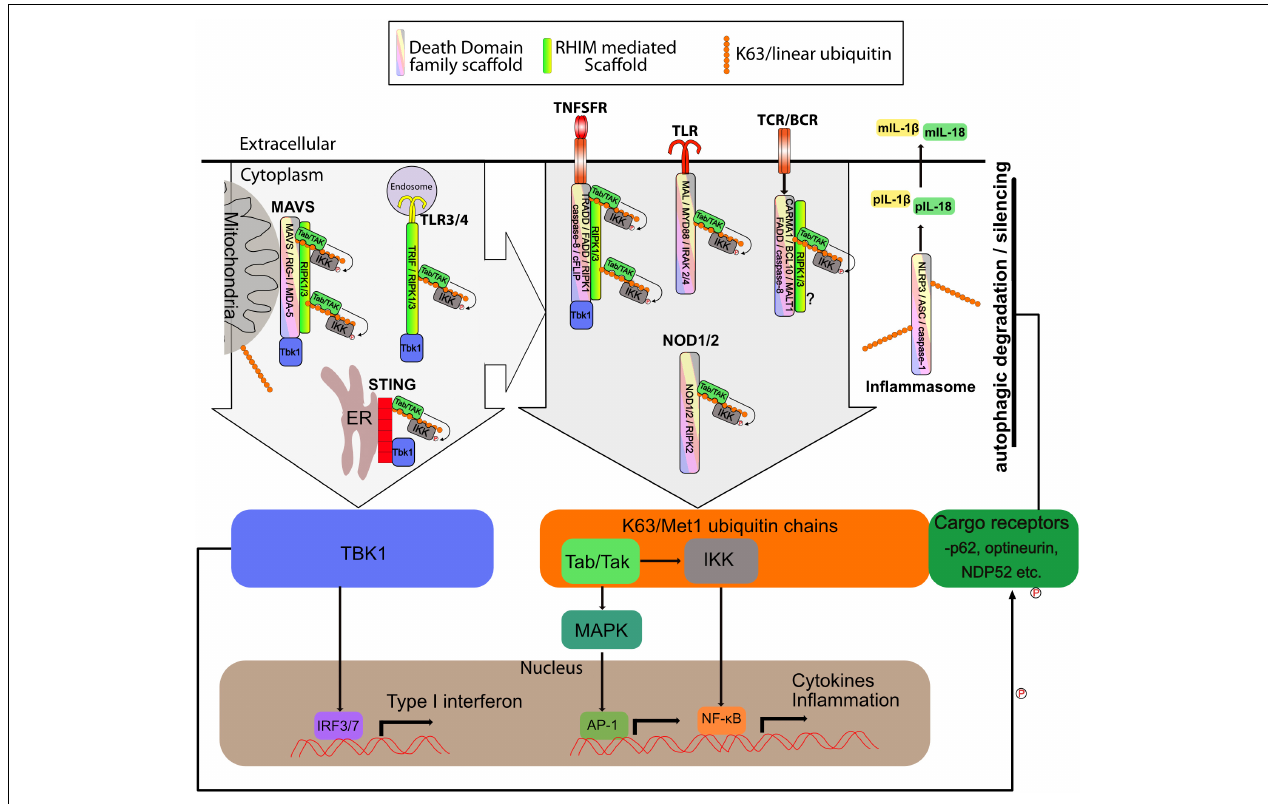
FIGURE 3 | Supramolecular signaling complexes in inflammation share common scaffolds and signaling pathways. The supramolecular signaling complexes formed by TLR, TNFSR, NOD1/2, STING, MAVS, Carma, BCL-10, MALT1 (CBM) and inflammasome complexes are indicated. Shown are the core scaffolds formed through death domain family interactions as well as RHIM interactions. STING contains no death domain family member or RHIM. Specific proteins known to interact through death domain interactions and RHIM interaction are indicated within each complex. Recruitment of TBK1 and/or K63/linear ubiquitin is indicated. TBK1 recruitment activates IRF3 to induce interferon responses. K63/linear ubiquitin recruits the TAB/TAK and IKK complexes which result in activation of NF-kB and Map kinase transcriptional responses. Also shown is linear/K63 ubiquitination of ASC of inflammasomes which can promote their assembly and activation or degradation. Complexes and organelles such as mitochondria that are k63 ubiquitylated recruit autophagy cargo receptors such as p62. This leads ultimately to degradation and silencing of the complexes. This is enhanced by TBK1 mediated phosphorylation of the cargo receptors. Other scaffolds such as those mediated via TRAF proteins are also present, but for simplicity have been omitted from the figure. DD family and RHIM scaffold are not meant to be to scale or reflect the actual organization of the scaffold, but simply indicate that each of these scaffolds are present.